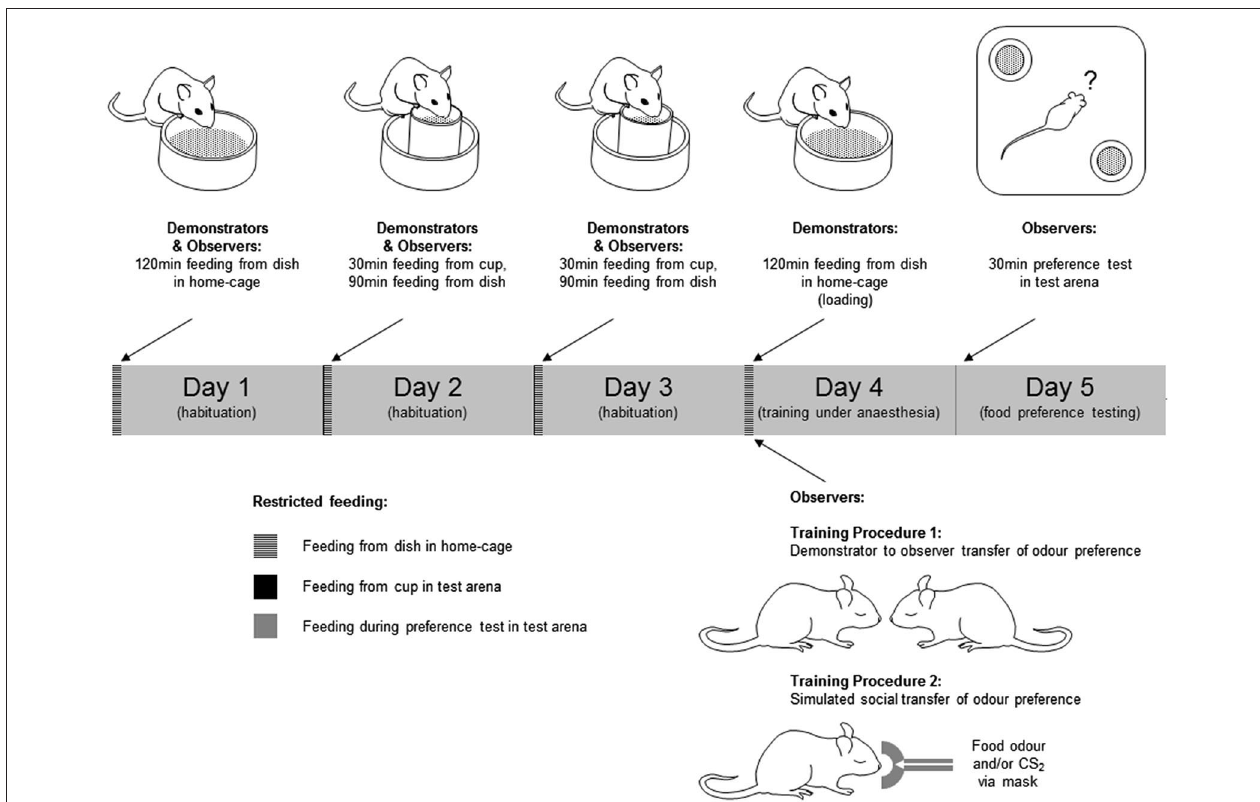
provided in a feed cup—a plastic cylinder (4 cm diameter × 5 cm high) fixed in the center of a plastic dish (6 cm diameter × 2 cm high) to catch any spillage ( Figure 1 ). On day 4, Demonstrator mice were “loaded” by being given unrestricted access to either a flavored food or the normal food, both in powdered form. Observer mice were anesthetized, and exposed to the training odor by one of two procedures; either (1) carried on the breath of an anesthetized demonstrator, or (2) introduced to the anesthetic gas with or without CS 2 . On day 5, mice were given a 30 min simultaneous choice test to determine their food preference. Mice which consumed none of either food in the preference test were excluded from further